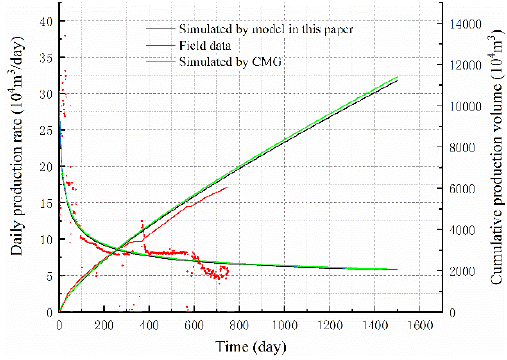
Figure 6. Comparison of the gas production rate of the model in this study and the CMG numerical model.